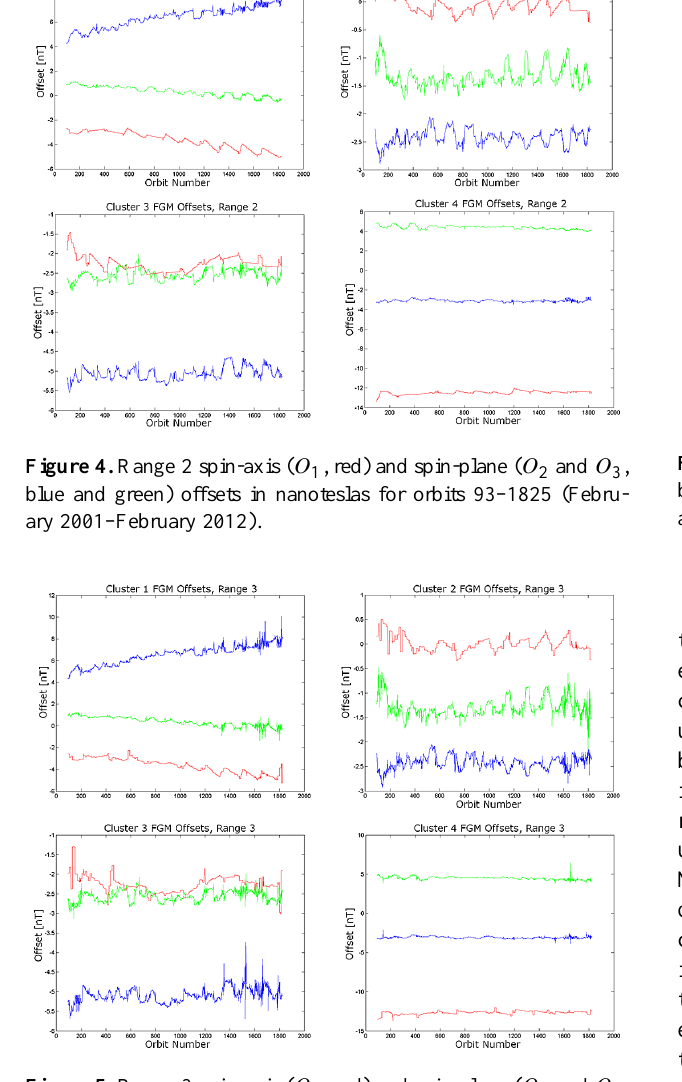
Figure 5. Range 3 spin-axis ( O 1 , red) and spin-plane ( O 2 and O 3 , blue and green) offsets in nanoteslas for orbits 93–1825 (Febru- ary 2001–February 2012).